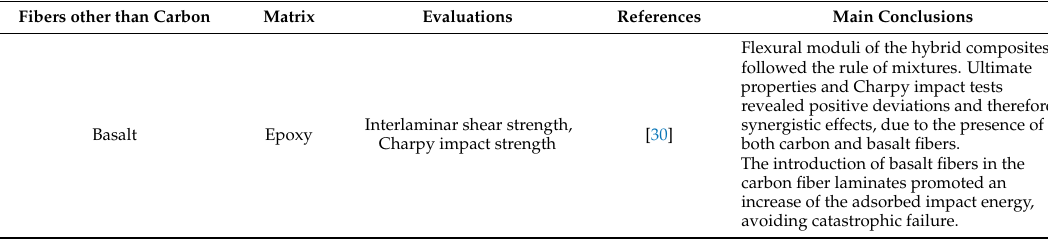
Table 3. Studies on hybrid composites including carbon fiber